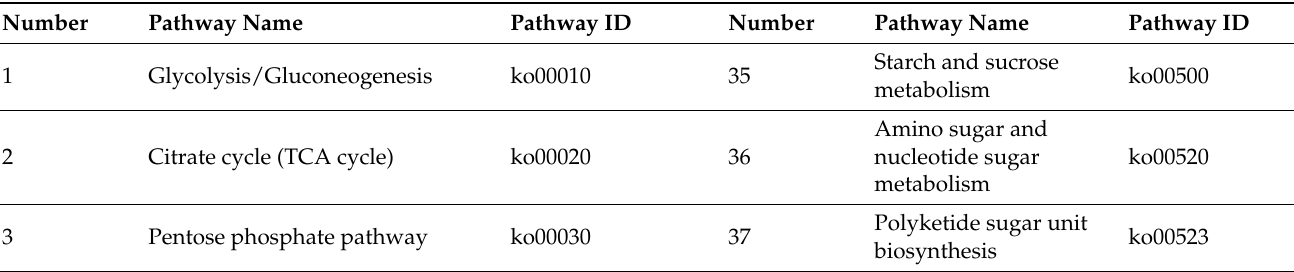
Table 1. List of pathway analysis in the embryos of maize under low − temperature stress.